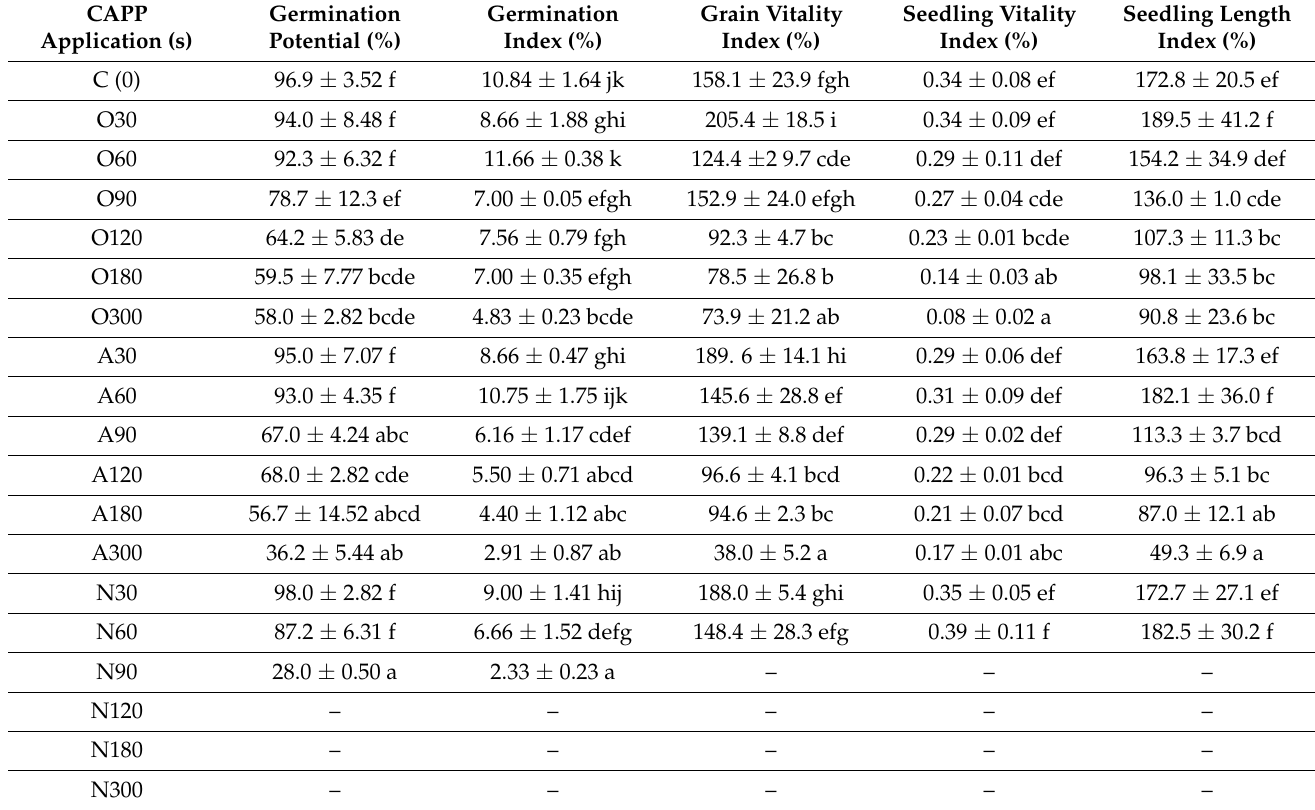
Table 1. Impact of different Cold Atmospheric Pressure Plasma (CAPP) applications on growth parameters of Zea mays L. cv. Ronaldinio. Grains were pre-treated with different variants of CAPP (C—control/untreated maize grains; O30–O300: grains treated with plasma generated in an oxygen atmosphere for 30, 60, 90, 120, 180 or 300 s; A30–A300: maize grains treated with plasma generated in ambient air for 30, 60, 90, 120, 180 or 300 s; N30–N300: maize grains treated with plasma generated in a nitrogen atmosphere for 30 and 60 s). Values in table represent means of at least 4 independent experiments (one experiment represents 10–20 measurement data) ± SD according to LSD ANOVA test. Different letters indicate significant difference at p < 0.05. Indexes were calculated according to Abdul-Baki and Anderson